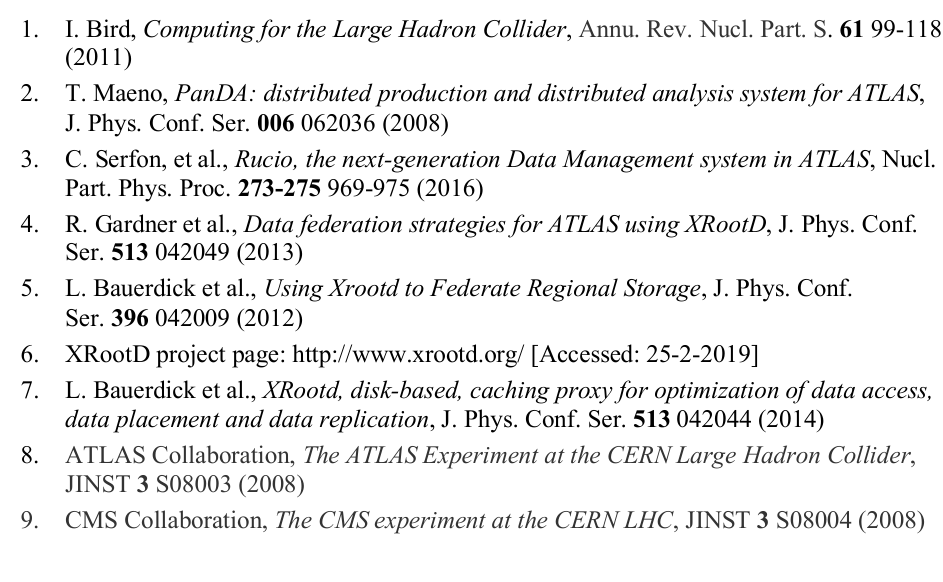
Figure 3. Hotness distribution of cached files Figure 4. Popularity tendency of cached